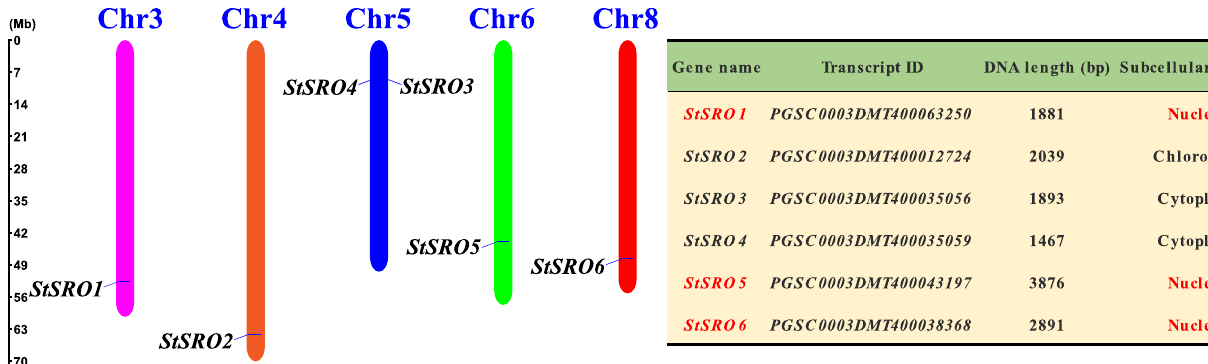
Figure 1. Chromosome location and basic information analysis of StSRO family members. Different colors represent different chromosomes. Chromosome numbers are shown at the top; StSROs were labeled on the left and right sides of the chromosome. The scale on the left shows chromosome length (in Mbp). The table on the right of chromosome shows StSRO family information and subcellular localization analysis.